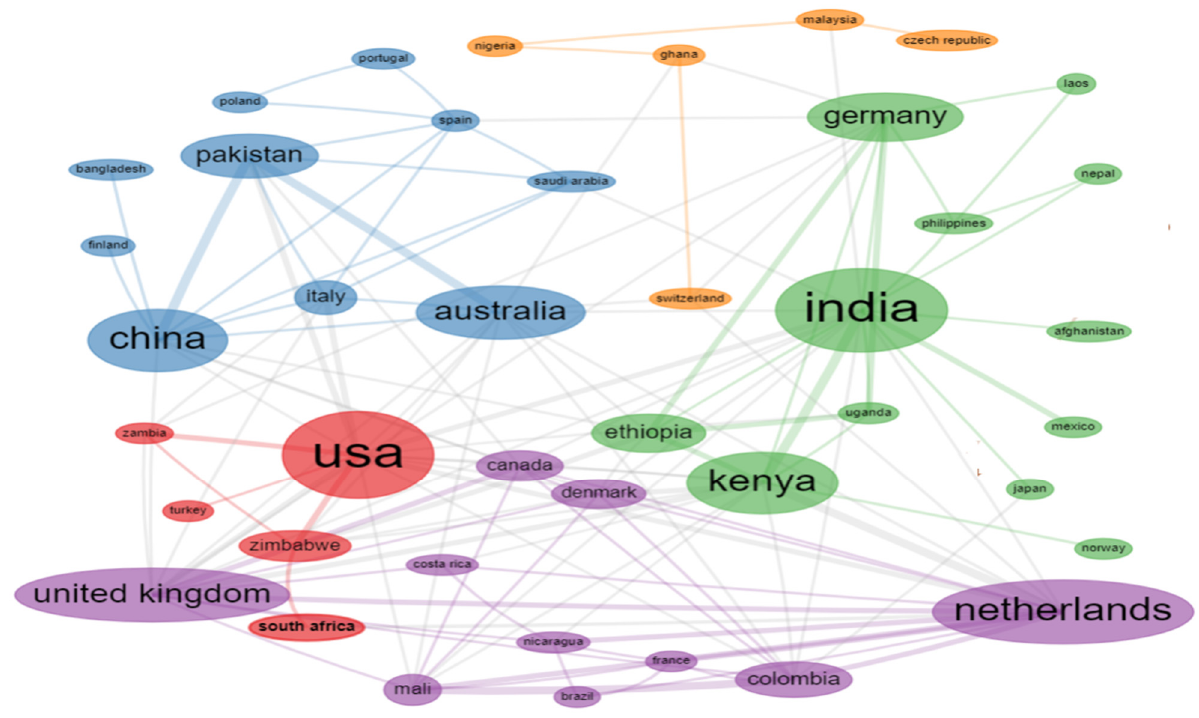
Figure 4. Nation collaboration networks. Table 7. Cluster of nation collaborations around the globe within the period 2009–2022.